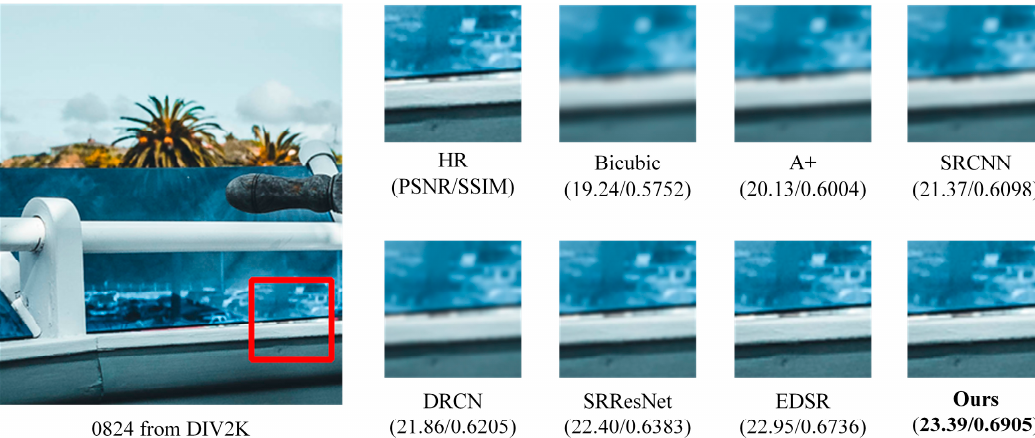
Figure 4. The results of “Image007” (Set14) on ×4 super-resolution. MRSR shows a better performance in the qualitative comparison with other methods.